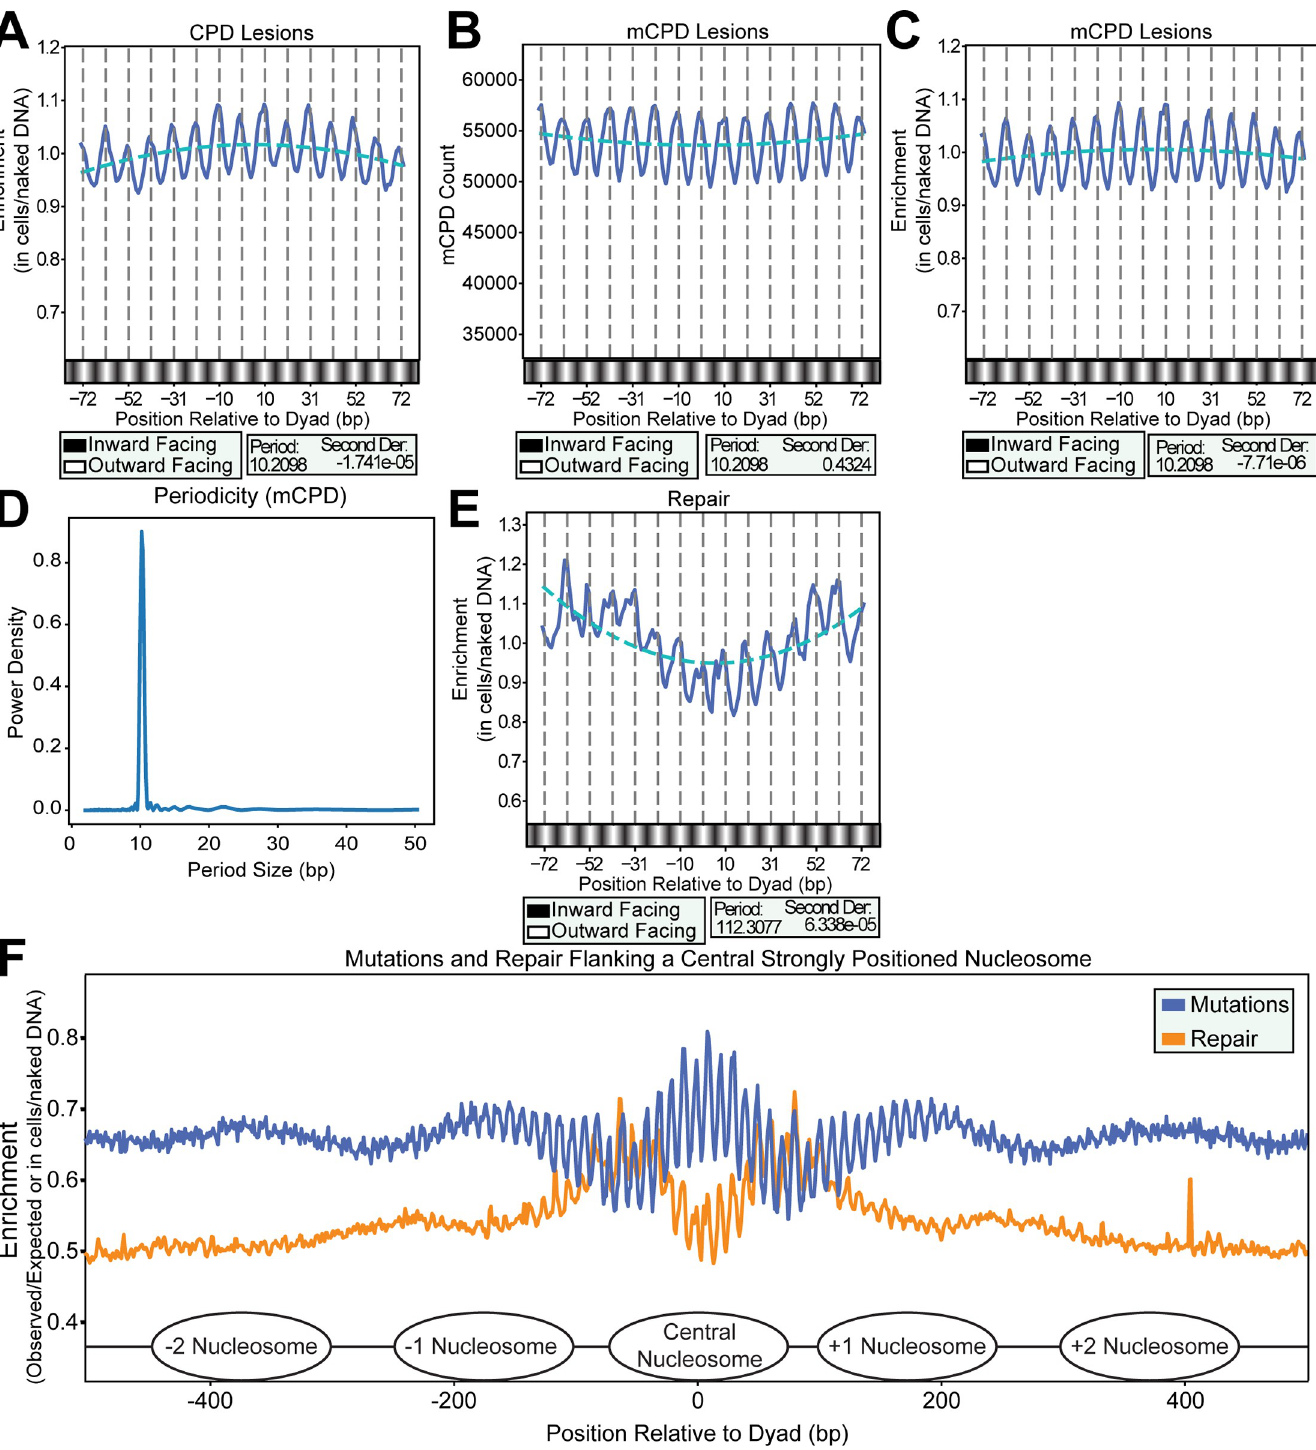
Fig 3. CPD lesions and repaired CPD lesions counted at nucleosome positions. ( A ) The “in cells” CPD lesion counts normalized to in vitro lesion counts (CPD-seq by CPD-seq; also normalized for read counts) at nucleosome positions showed the same periodicity observed in the mutation data. They also showed a slight negative curvature across the nucleosome. ( B ) The mCPD lesion counts and ( C ) mCPD lesions normalized to in vitro lesion counts showed the same periodicity as all CPDs ( D ), however, they showed an even more shallow negative curvature. ( E ) The in cells CPD repair counts normalized to in vitro CPD lesion counts (XR-seq by HS-Damage- seq; also normalized for read counts) at nucleosome positions appeared to have the same periodicity. However, the most significant periodicity by Lomb-Scargle analysis